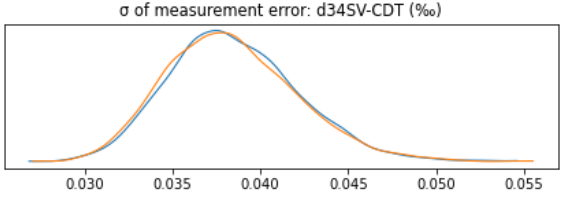
Figure 7. Distribution of standard deviation of measurement error.